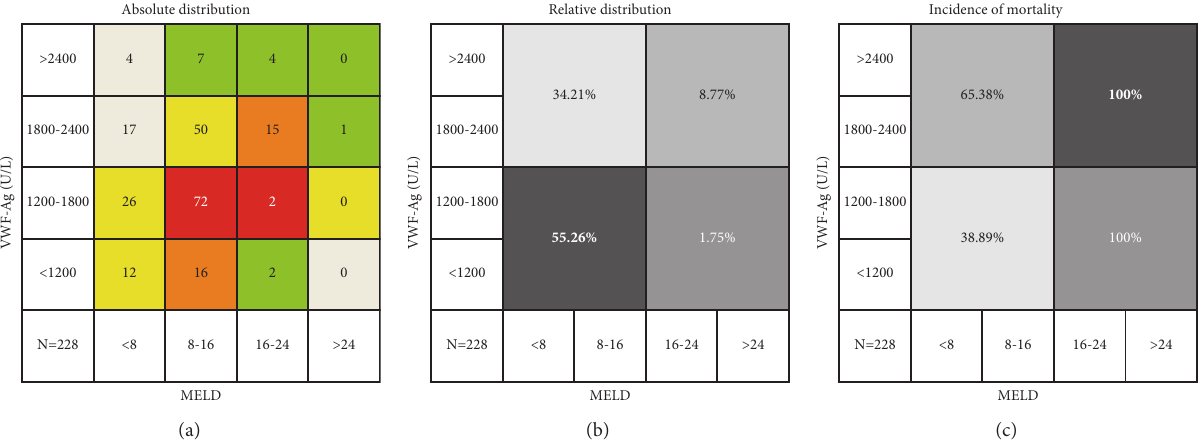
Figure 2: Association of vWF-Ag and MELD in patients with cirrhosis. (a) Absolute distribution of patients in regard to their vWF-Ag levels and MELD; (b) the relative distribution of patients in regard to their vWF-Ag levels and MELD; (c) the transplant-free mortality of patients with liver cirrhosis during follow-up in regard to their vWF-Ag level and MELD.